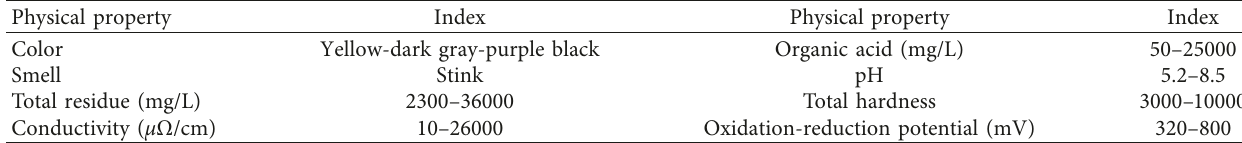
Table 1: Physical properties of leachate.